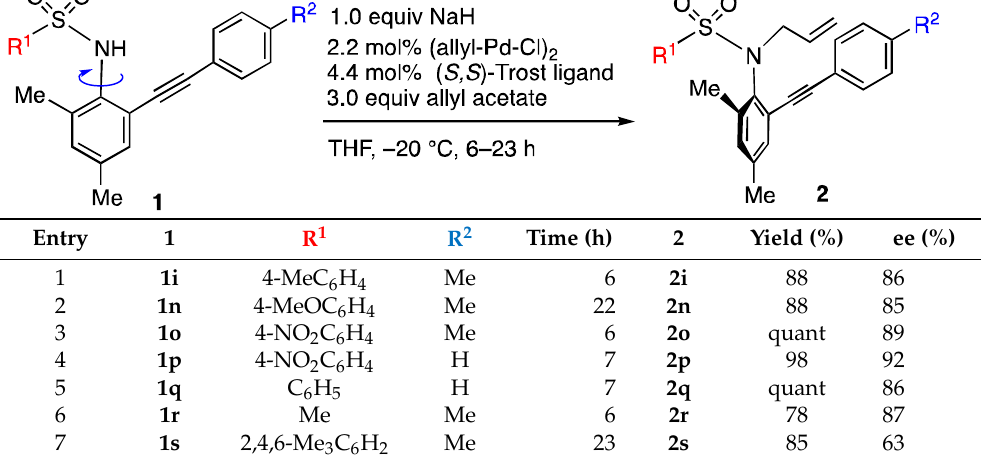
Table 3. Substituent effect on sulfonyl group in enantioselective N -allylation.